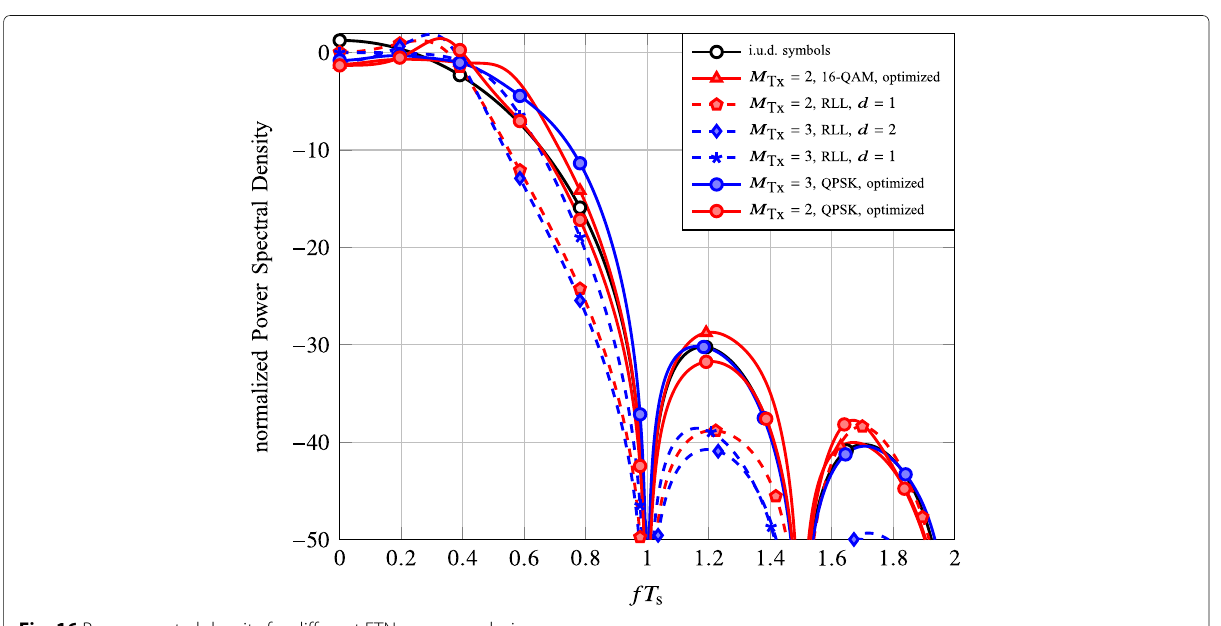
Fig. 16 Power spectral density for different FTN sequence designs